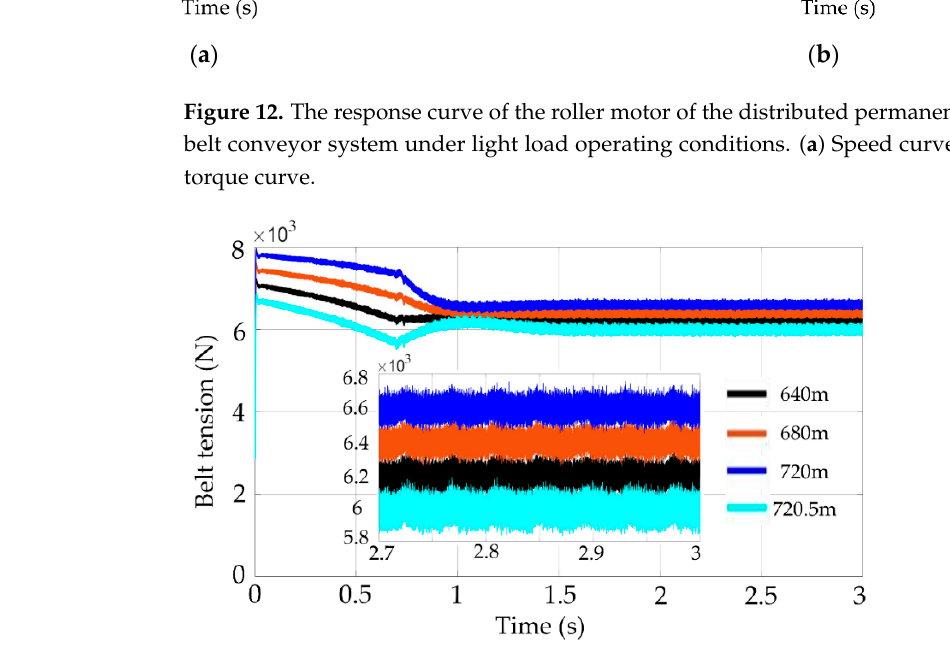
Figure 13. Conveyor belt tension waveform diagram on the 6 group of driving mechanism under light load operating conditions.